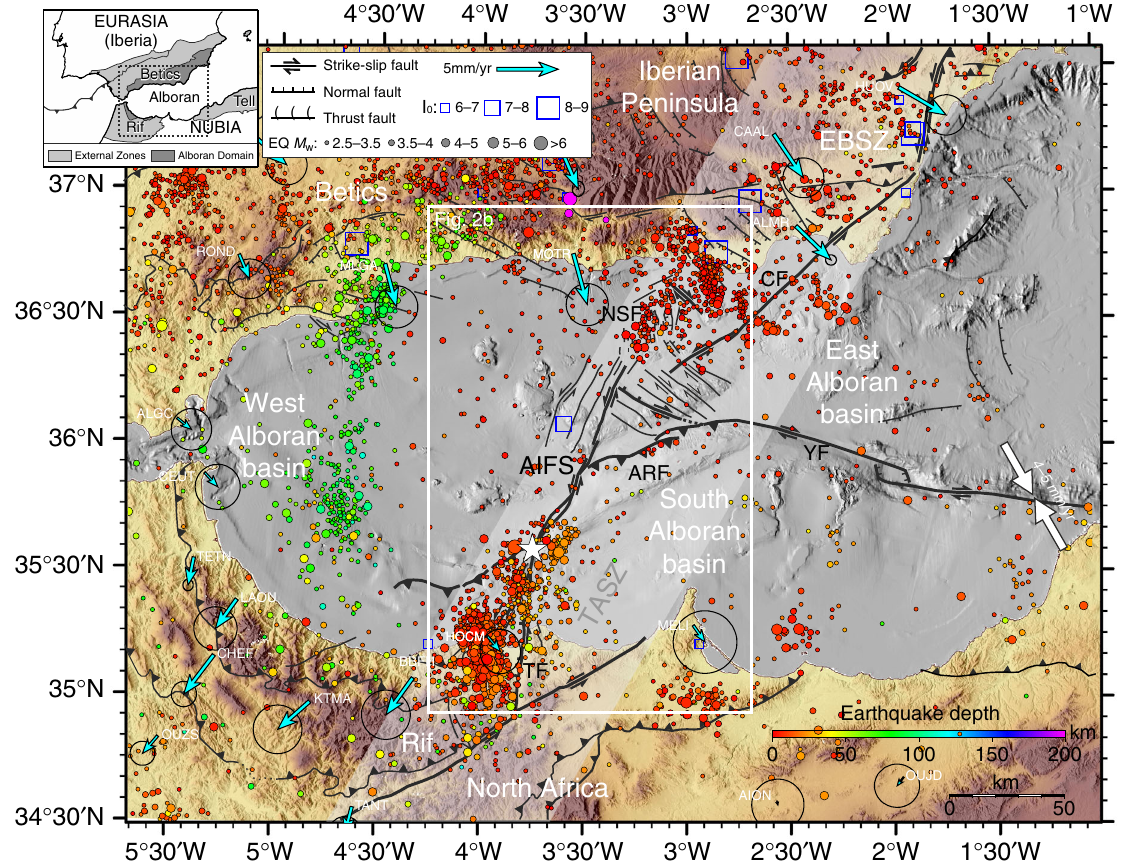
Fig. 1 Tectonic setting, seismicity and GPS velocities in the Alboran Sea region. Topography and bathymetry of the Alboran Sea. Historical (1400 – 1960) and instrumental (1980 – 2015) seismicity previous to the 2016 event are colour-coded according to hypocentre depths. The GPS velocity fi eld is drawn with respect to Nubia 24 (blue arrows), and Eurasia-Nubia relative motion 6 (white arrows). The main faults located on the map are: AIFS: Al-Idrissi Fault System; ARFS: Alboran Ridge Fault System; CFS: Carboneras Fault System; NSF: North-South Faults; EBSZ: Eastern Betic Shear Zone; TASZ: Trans-Alboran Shear Zone; TF: Trougout Fault. HOCM: Al-Hoceima; YFS: Yusuf Fault System; MELI: Melilla. Upper left: Con fi guration of the Eurasia and Nubia Plates in